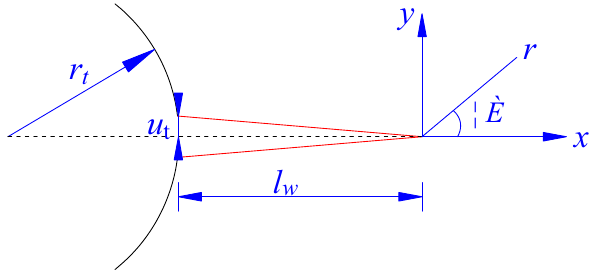
Fig. 2 Fracture development model with underwater blasting